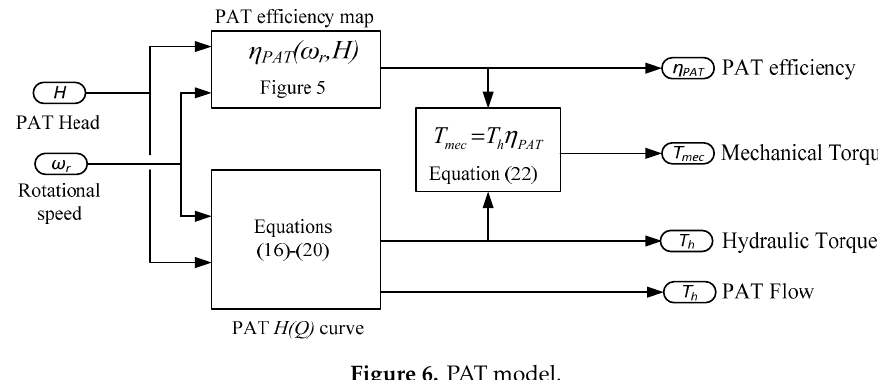
Figure 6. PAT model.